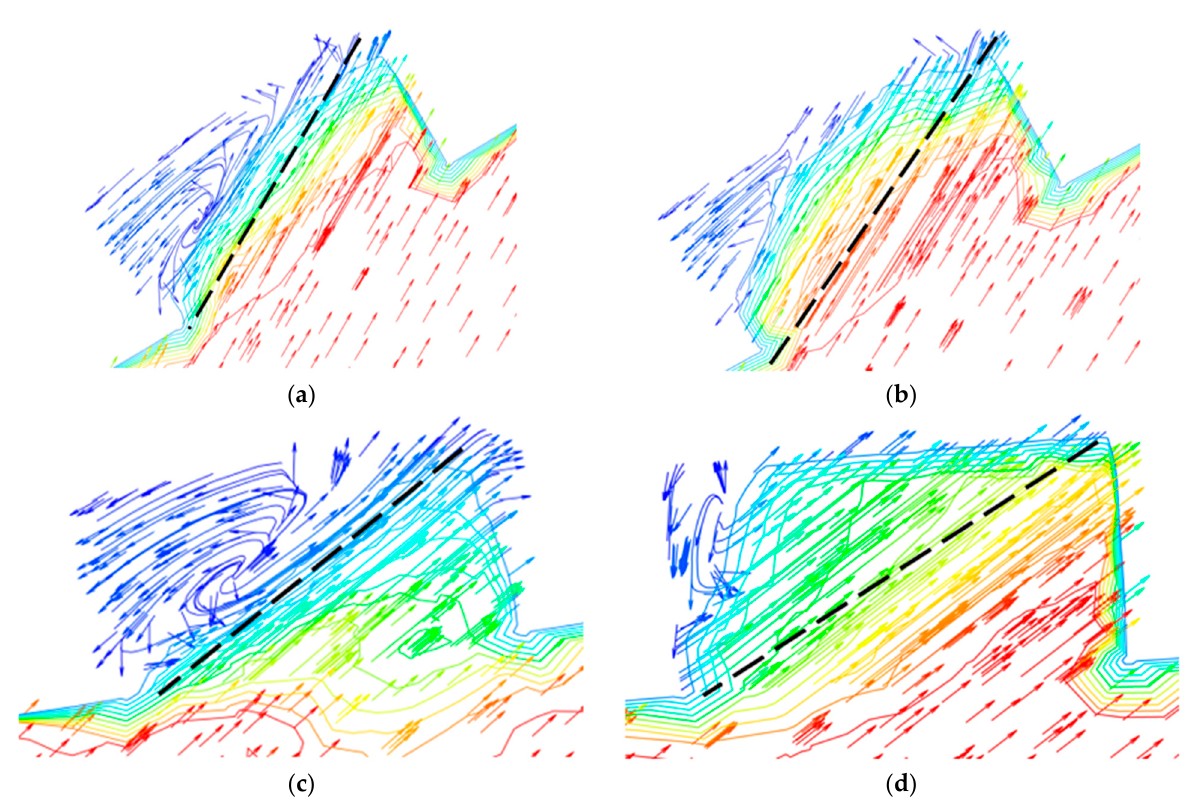
Figure 18. Velocity distribution and streamline of the liquid phase.